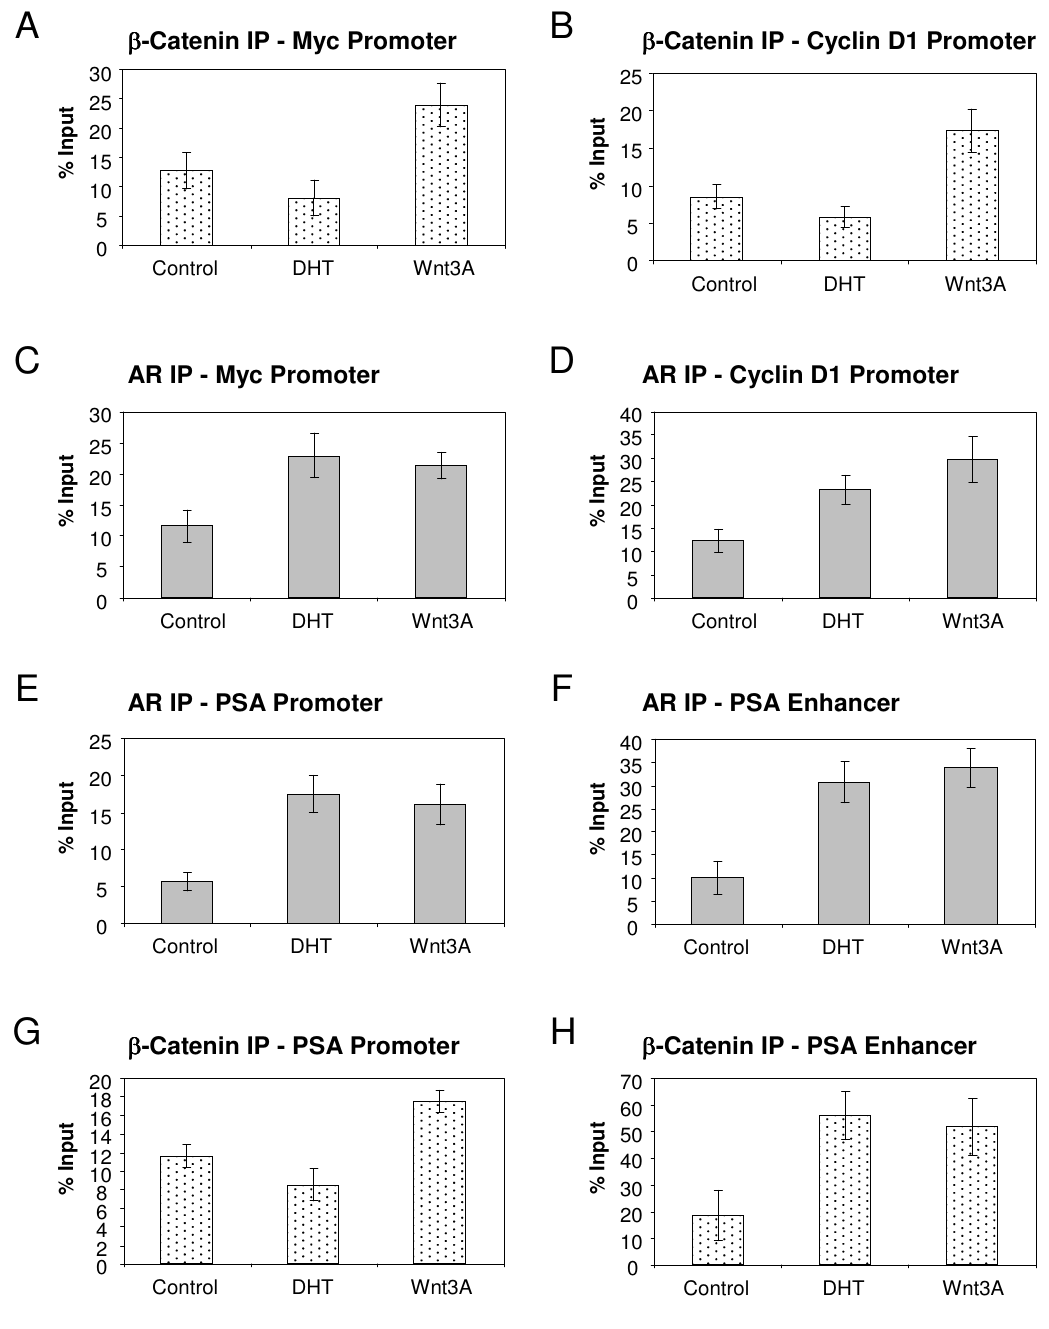
Figure 6 The recruitment of AR and β -Catenin to Wnt signaling target genes as well as PSA promoter and enhancer region using CHIP analysis . LNCaP cells in phenol-red free RPMI with 5% charcoal-stripped serum were treated with either 10 nM DHT, 100 ng/ml Wnt3A, or no treatment for 16 hours before cross-linking. Anti- β -Catenin (A, B, G and H) and anti-AR (C, D, E and F) antibodies, together with negative control IgG were then used for immunoprecipitation. After reverse crosslinking and DNA purification, PCR products were analyzed using the Agilent 2100 bioanalyzer. Percent of input is shown here to compare the levels of β -Catenin or AR at the promoter or enhancer region of PSA, or the promoter region of Cyclin D1 or